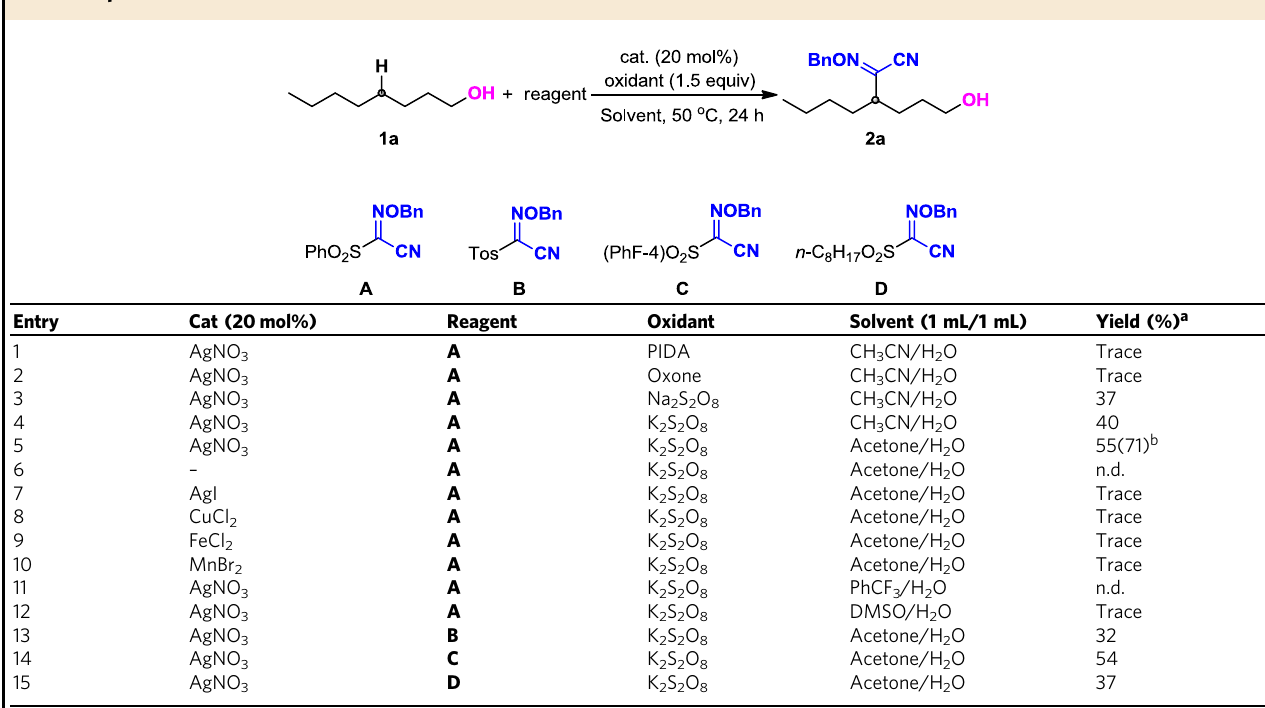
Table 1 Optimization of reaction